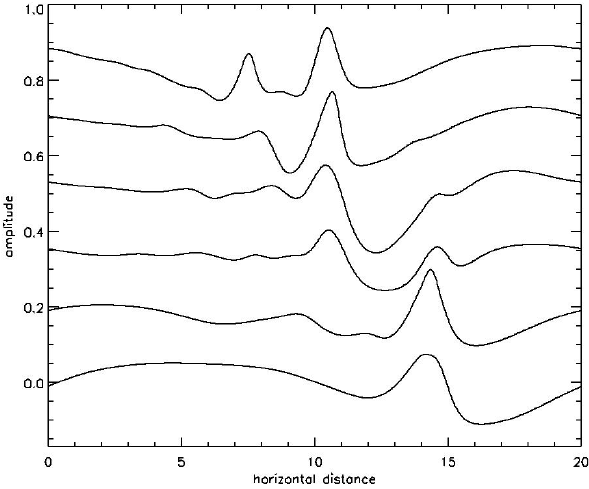
Fig. 9. Cuts take through the contours in Fig. 8 at z = −